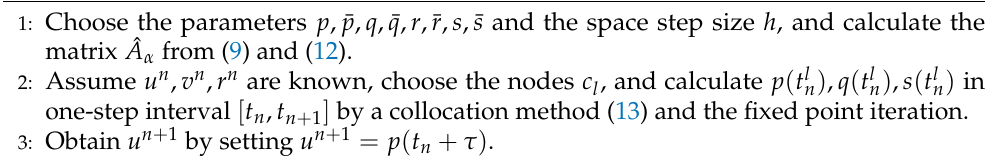
Algorithm 1 The SAV-WSLD-Gauss method